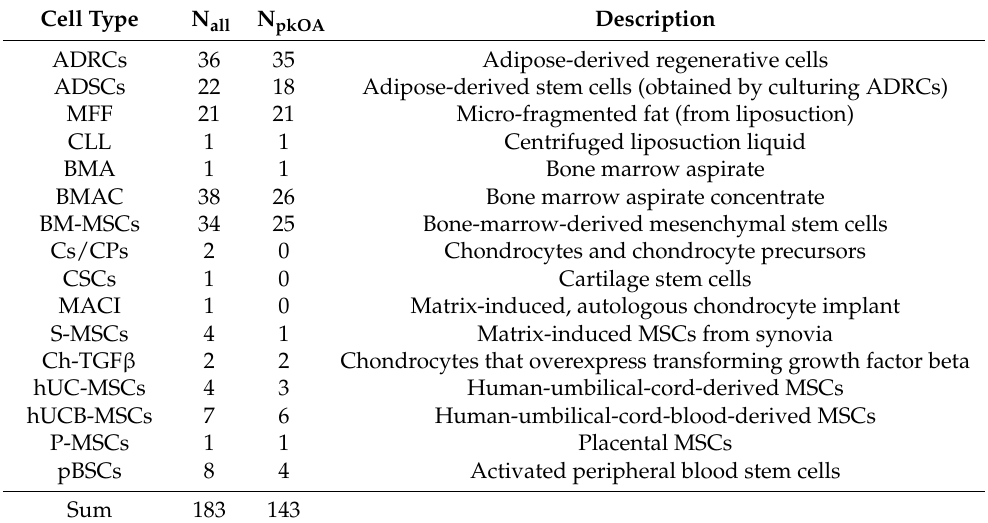
Table 8. Types of stem cells used in studies on management of primary knee osteoarthritis with stem cells that were identified during an evidence-based, systematic review of the literature according to the PRISMA guidelines [198] performed on 7 August